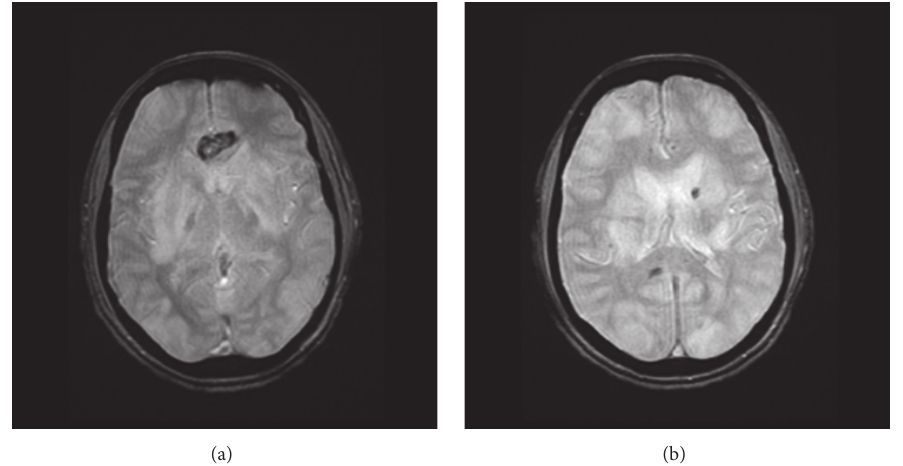
Figure 3: MRI Brain-Axial gradient echo-weighted images demonstrate susceptibility effect in the genu and splenium of the corpus collosum as well as the left frontal periventricular white matter compatible with multifocal